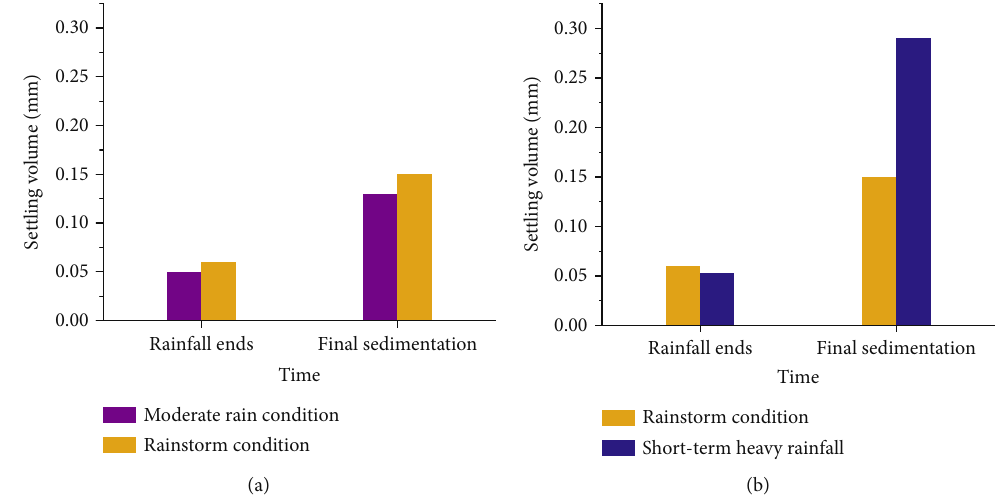
Figure 12: Variation of fi nal sedimentation of fi ll under di ff erent rainfall conditions: (a) fi nal sedimentation under di ff erent rainfall intensities with the same rainfall duration; (b) fi nal sedimentation under di ff erent rainfall intensities with the same rainfall